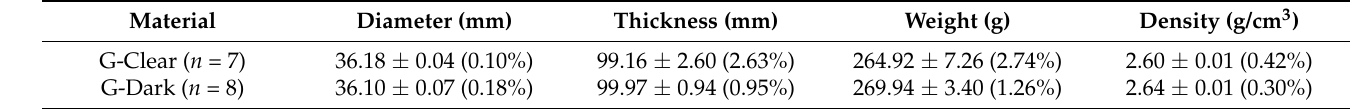
Table 13. Main physical results of tested granite pieces.